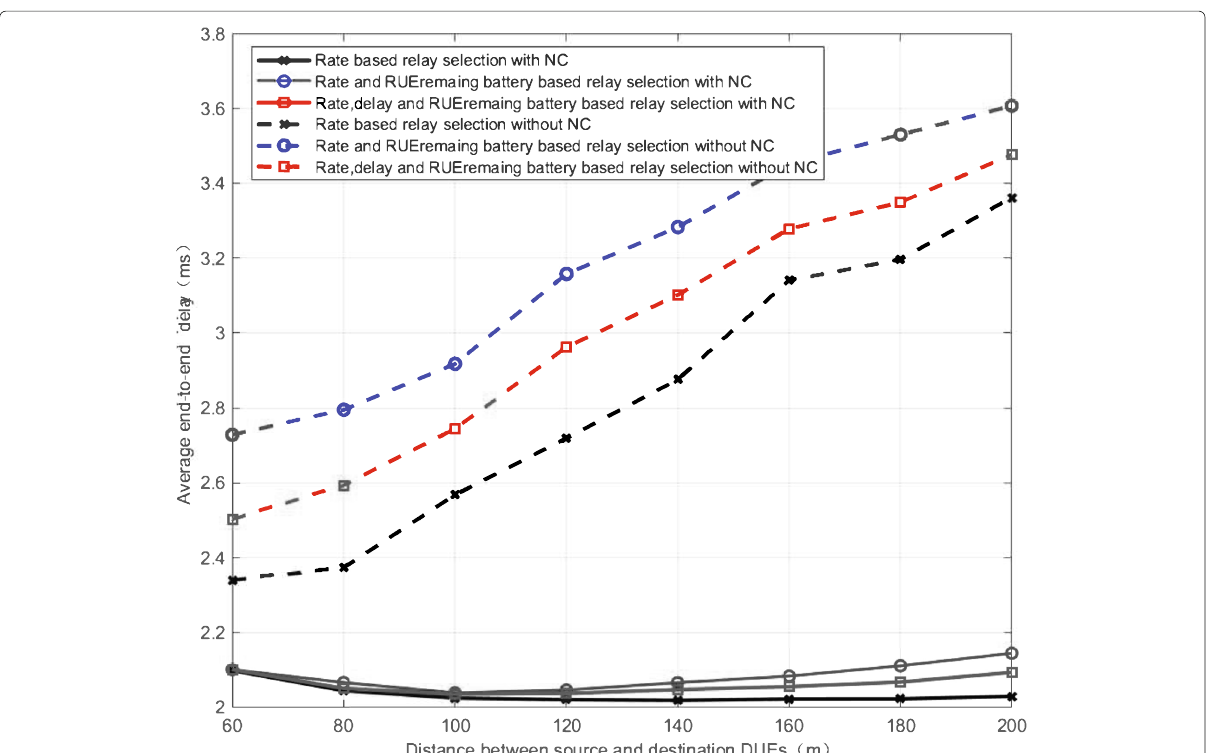
Fig. 7 The average end-to-end delays of the three relay selection methods with and without network